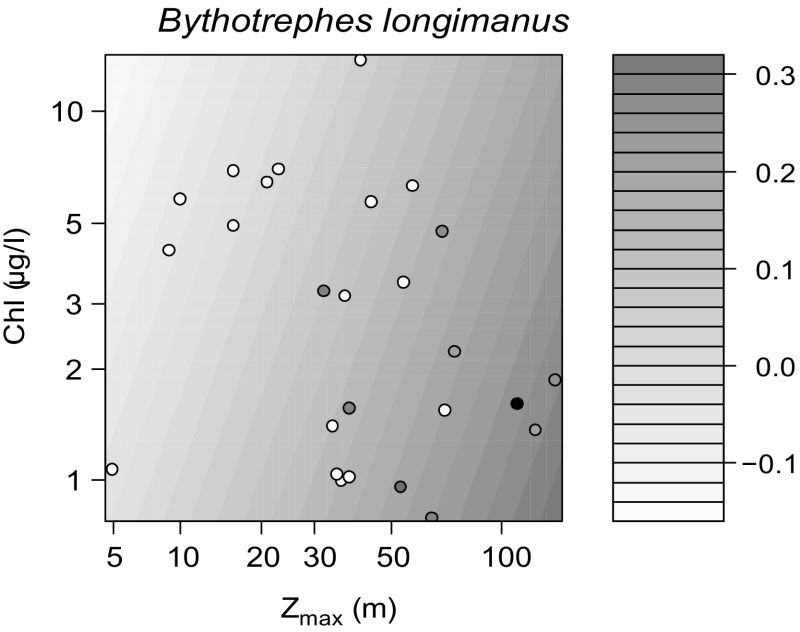
 Empirical linear regression model (R
2 = 0.37) predicting the abundance (ind L−1) of Bythotrephes longimanus in the Austrian and German lakes from lake depth (Z
max; p = 0.007) and chlorophyll a concentrations (Chl-a; p = 0.22), which were the strongest predictors of its occurrence (see Table 3). Points show the original empirical data, and surface is the fitted model, with darker grey as higher abundance.